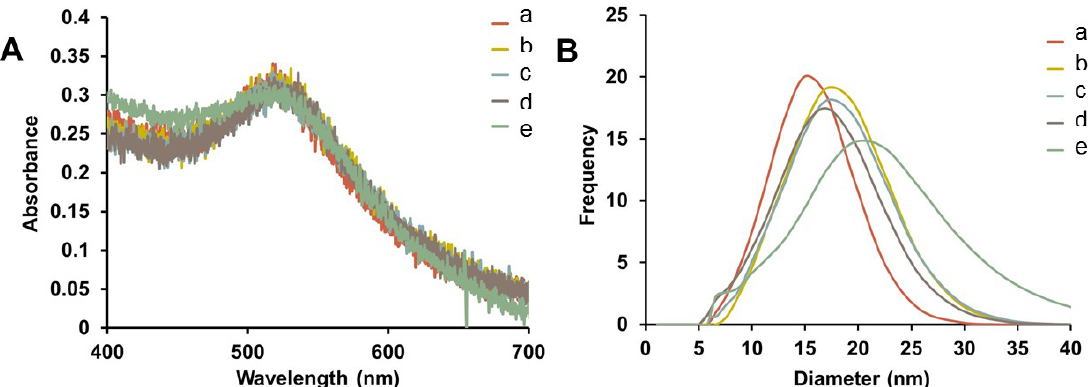
Figure 2. ( A ) Representative UV-Vis spectra and ( B ) hydrodynamic diameter comparison from DLS of AuNPs (a) Au-GSH, (b) Au-GSH-(Trp) (His) , and (e) Au-GSH-(DanArg) 2